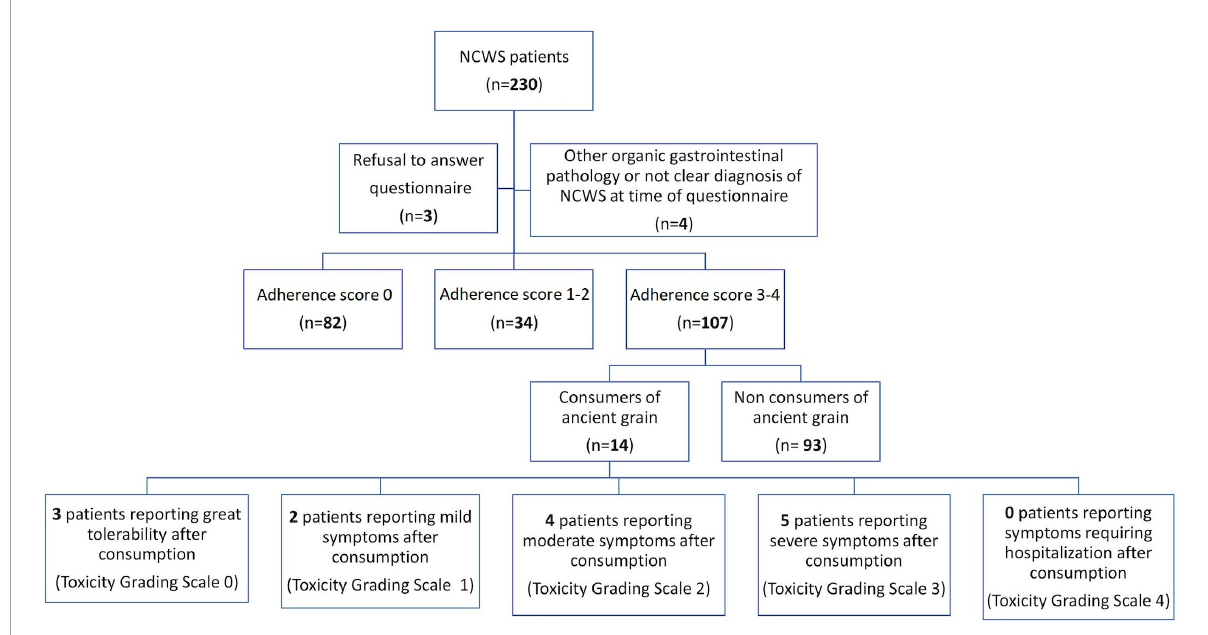
FIGURE1 Flow-chart of the study, showing patient adherence to a modern wheat-free diet and consumption of ancient grains after Non-celiac Wheat Sensitivity (NCWS) diagnosis.